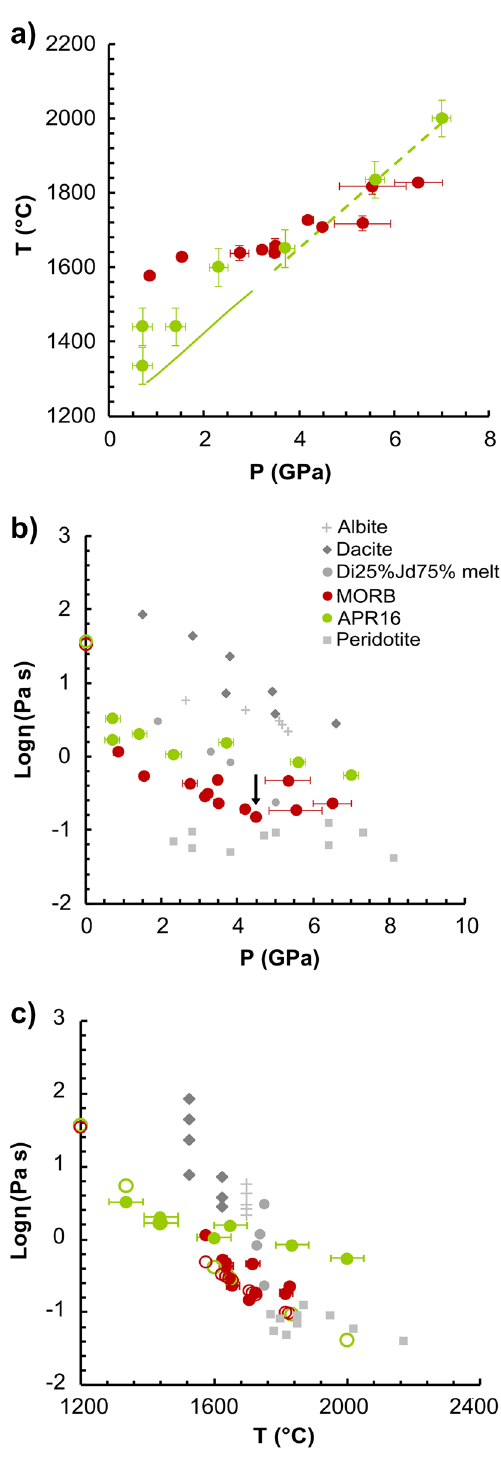
Figure 1. ( a ) Experimental P and T for APR16 (this study) and MORB 8 experiments. The green line indicates the liquidus T obtained experimentally 19 for APR16 using MELTS software 83 and extrapolated to higher P (dotted segment). ( b ) and ( c ) Diagrams showing the logarithm of the measured viscosity on APR16 (this study) plotted as a function of ( b ) pressure (P) and ( c ) temperature (T) and compared with the experimental data available for peridotite 7 , MOR basalt 8 , diopside-jadeite (trachy-andesite 9 ), albite 10 , and dacite 11 compositions. The black arrow indicates the pressure at which a viscosity turnover was observed by Sakamaki et al. 8 for MORBs and explained with the rapid densification (i.e. pressure-induced structural change). The empty circles ( b , c ) are the viscosities calculated for MORB and APR16 by using the model of Giordano et al . 5 at ambient P and T of 1200 °C ( b ) and ( c ) at the same T of the experiments. Error bars for the viscosity data from this study are within the symbols size. The pressure and temperature uncertainties for our data are ± 0.2 GPa and ~ 50 °C 71 ,